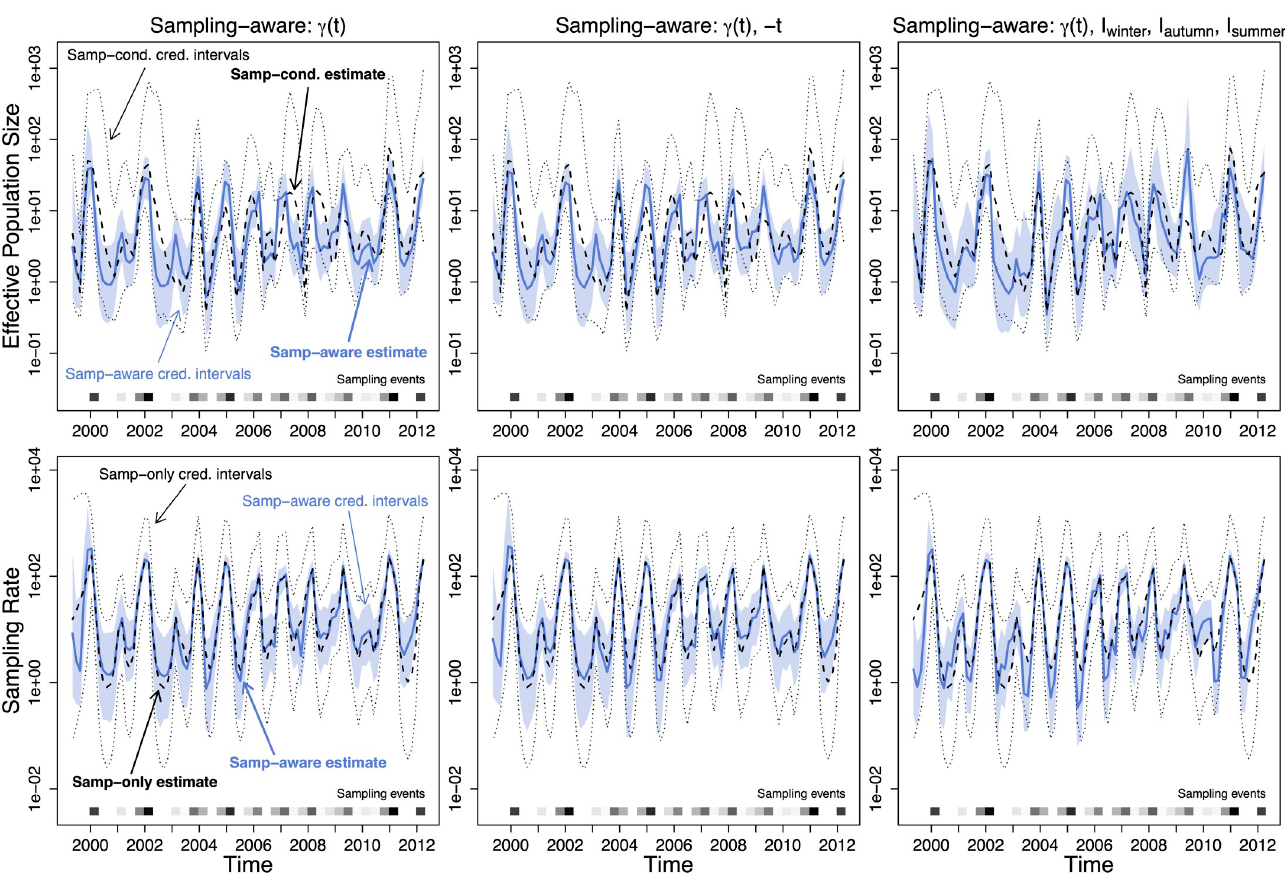
Fig 5. Effective population size and sampling rate reconstructions for the USA and Canada influenza dataset. Upper row : Dashed lines and dotted black lines are the pointwise posterior effective population size estimates and credible intervals of the sampling-conditional model. The blue lines and the light blue regions are the pointwise posterior effective population size estimates and credible intervals of that column’s sampling-aware model. Lower row : Dashed lines and dotted black lines are the pointwise posterior sampling rate estimates and credible intervals of a nonparametric sampling-time-only model. The blue lines and the light blue regions are the pointwise posterior sampling rate estimates and credible intervals of that column’s sampling-aware